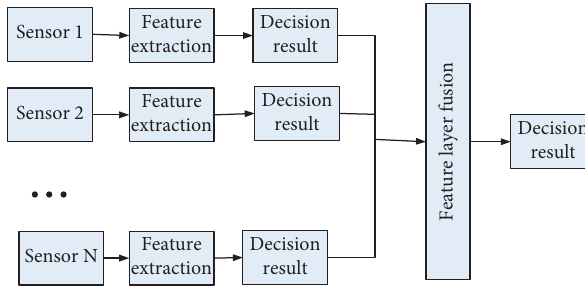
Figure 10: Decision-making layer fusion.